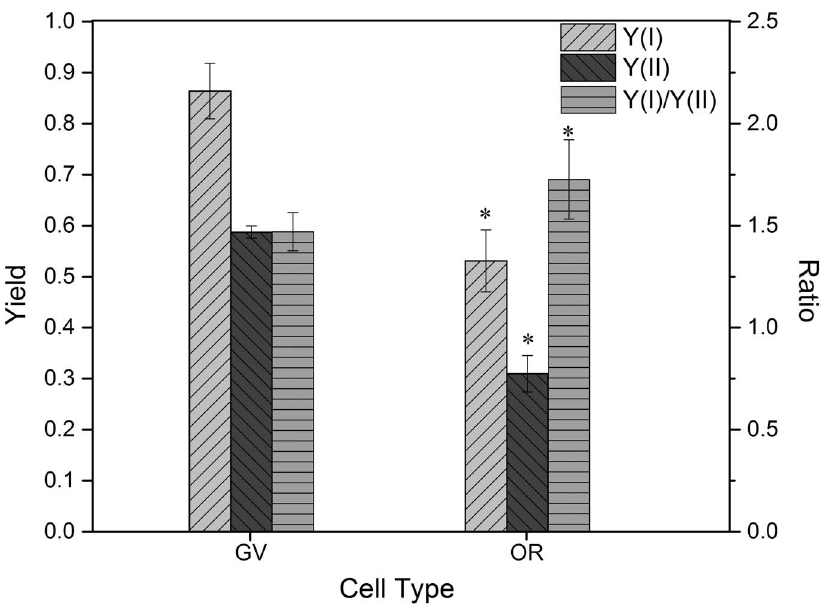
Figure 3. PAM analysis of chlorophyll fluorescence in GV and OR cells. Both Y(I) and Y(II) of GV were comparatively higher than OR. However, for ratio of Y(I) to Y(II), OR (1.72) was higher than GV (1.47). Y(I), Photochemical quantum yield of PS I; Y(II), Effective PS II quantum yield.